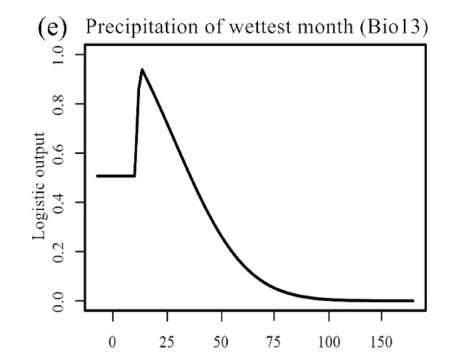
Figure 3. Response curves for dominant environmental variables.